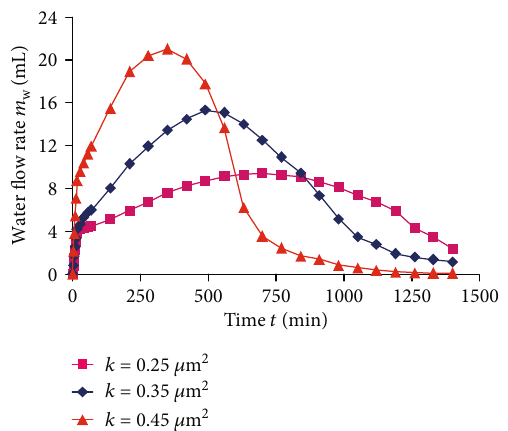
Figure 8: The e ff ect of intrinsic permeability on water fl ow rate in 3-D marine sediments under depressurization.